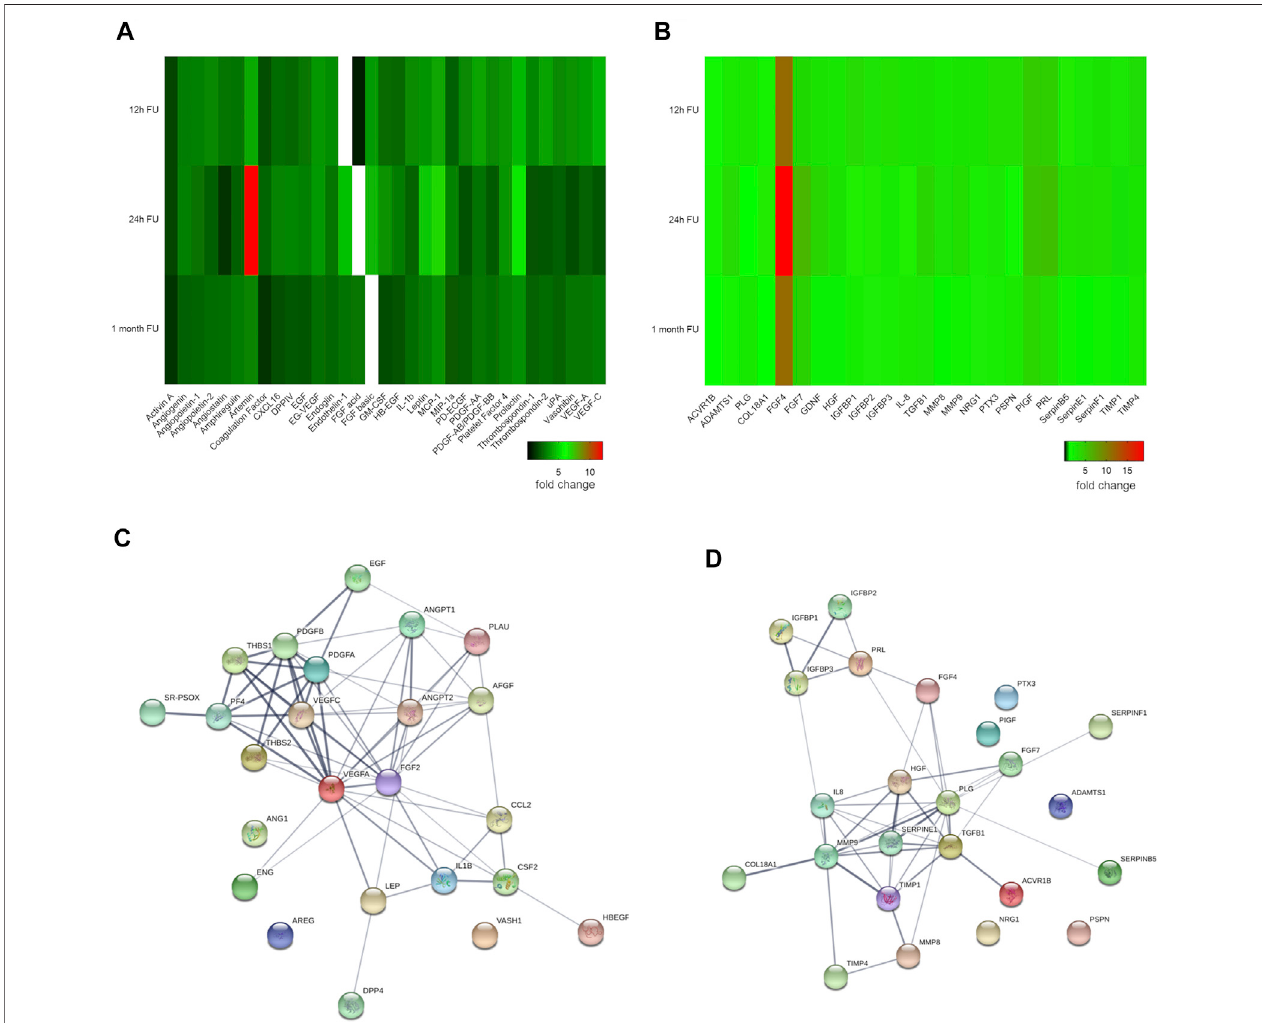
FIGURE 3 | Angiogenesis and cell-matrix adhesion proteome pro fi le. Heat maps show (A) angiogenesis and (B) cell-matrix adhesion related protein expression at 12 h, 24 h, and 1 month after injection of pMSC-MiCi-HIF1 α . Protein levels are normalised to those in baseline samples (i.e. before cell injections), with heat map data representing relative changes according to the color legend. (C,D) String protein network analyses show functional protein interactions of the investigated proteome in Sus scrofa, irrespective of quantitative changes of the individual proteins. Line thickness indicates the degree of con fi dence of the interaction, based on curated experimental data, predictions from genomic context analysis, and text mining. Node colors are merely for illustration purposes. n = 3 biological replicates for short term pMSC-MC-HIF1 α follow up, n = 3 biological replicates for control infarct